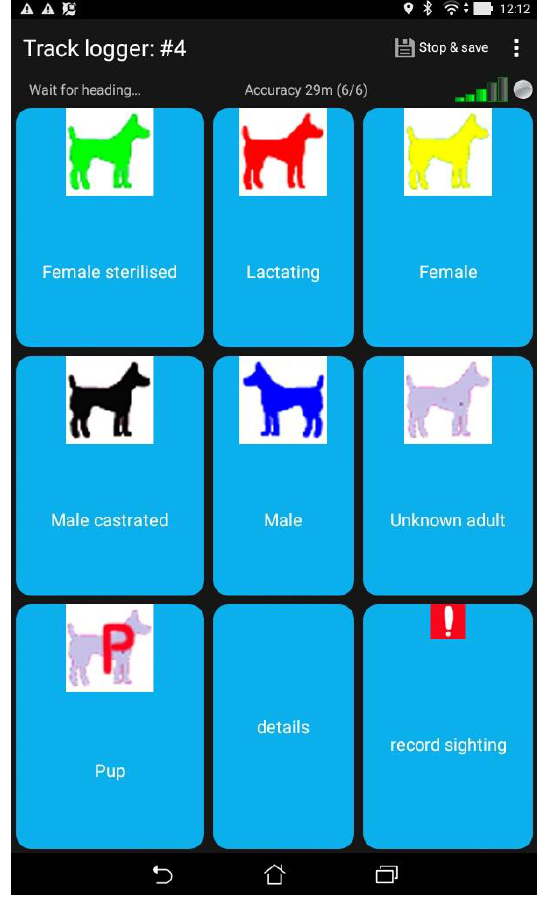
Figure 2. Image of OSMtracker app display on a mobile phone, showing an icon for each dog type recorded during surveying.